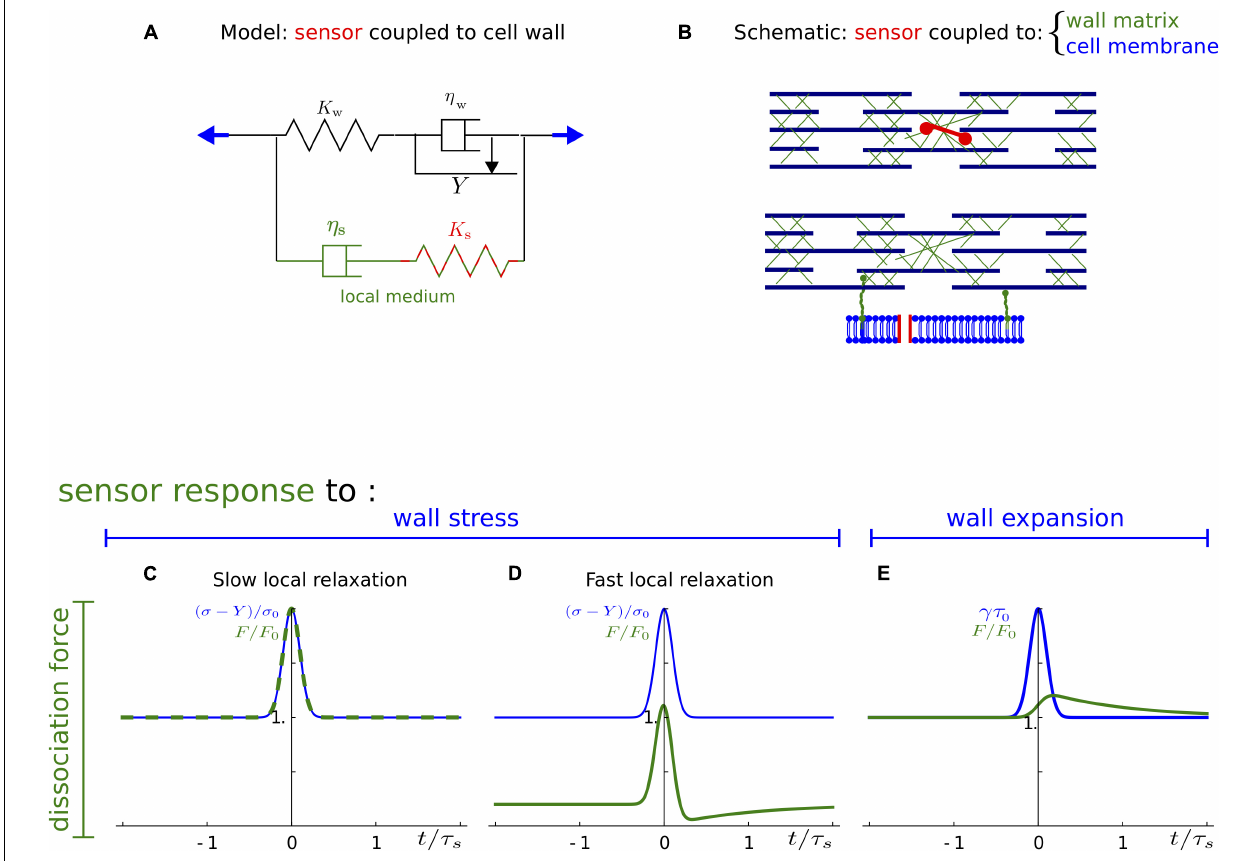
FIGURE 4 | Sensor associated with a minor load-bearing structure. (A) The sensor and the structure with which it is associated are schematically represented by a spring in parallel to the cell wall. The elastic modulus K s accounts for the sensor and the structure in which it is inserted. The viscosity η s is a property of the structure, only. (B) Schematic of the cell wall showing that the minor load-bearing structure may be a matrix component or the plasma membrane. (C–E) Response of the sensor to a mechanical signal: stress (C,D) or strain/expansion (E) . Mechanical signal (input, blue) and dissociation force (output, green) are plotted as a function of time. Stress is normalized using the yield threshold, Y ; and an arbitrary stress level, σ 0 ; expansion rate is normalized by 1 / τ 0 = σ 0 /( K w τ s ) ; dissociation force is normalized by